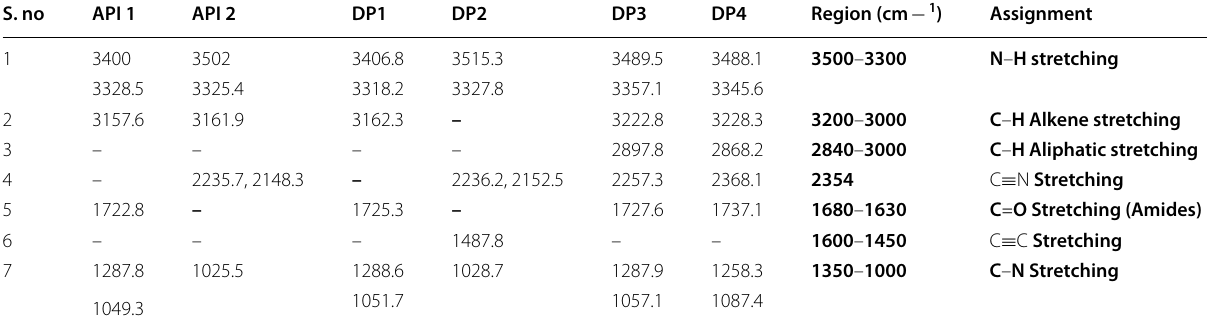
Table 9 FTIR data of Cabotegravir, Rilpivirine, and its degradation